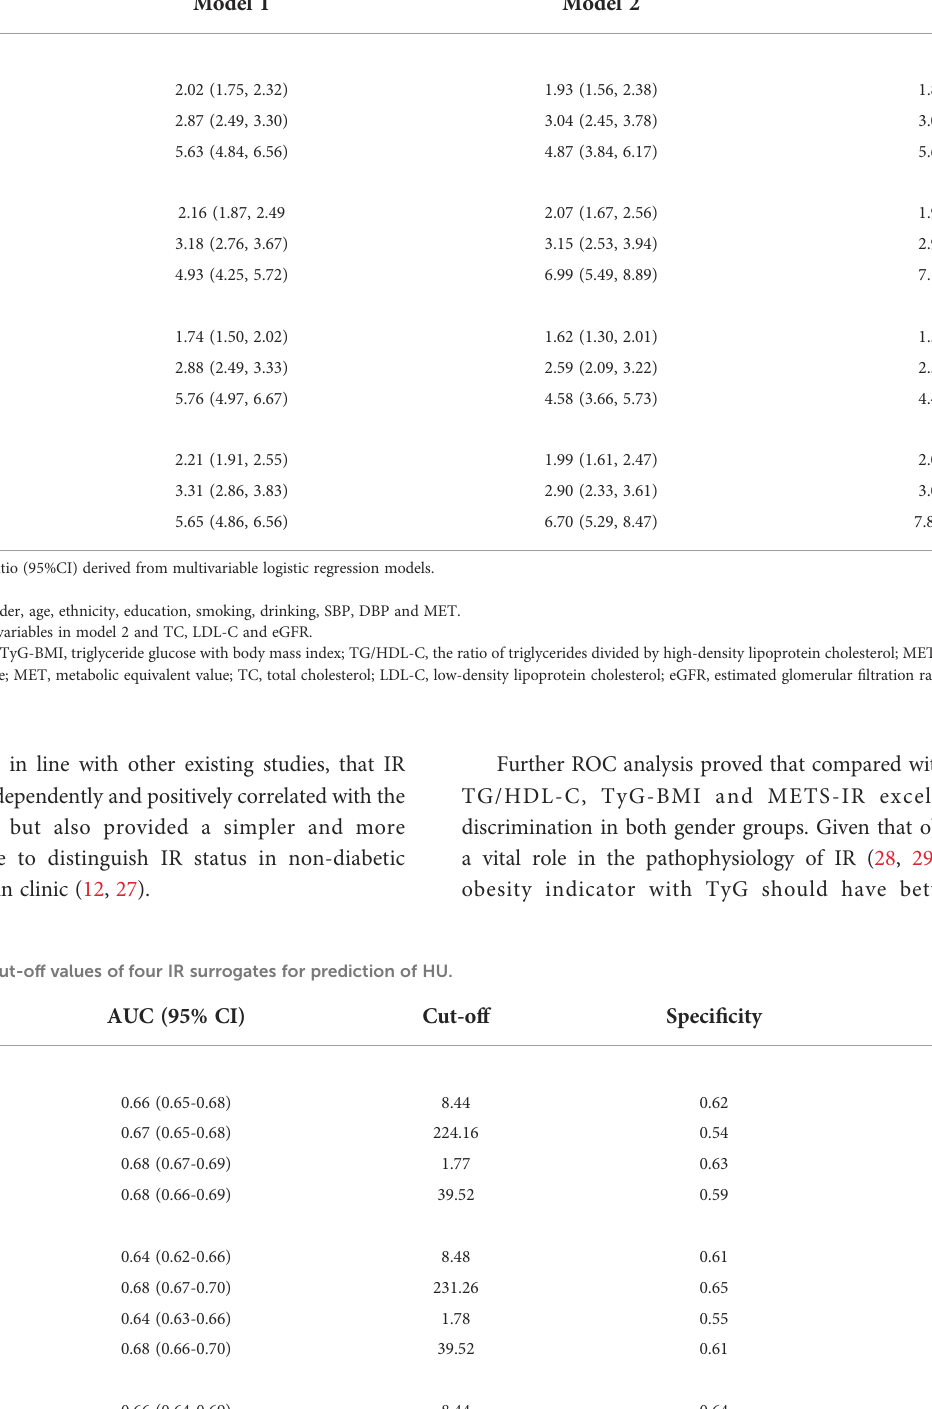
TABLE 2 ORs and 95% CIs for highest versus the lowest quartiles in logistic regressions predicting presence of HU.